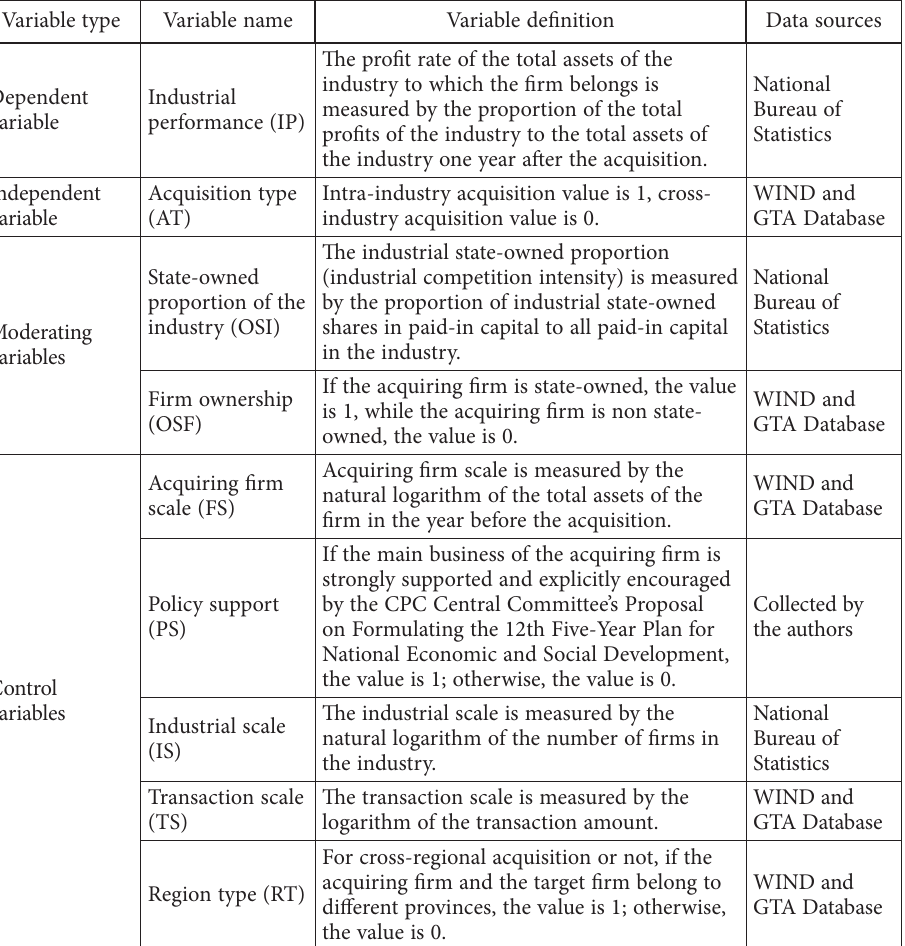
Table 1. Description and measurement of